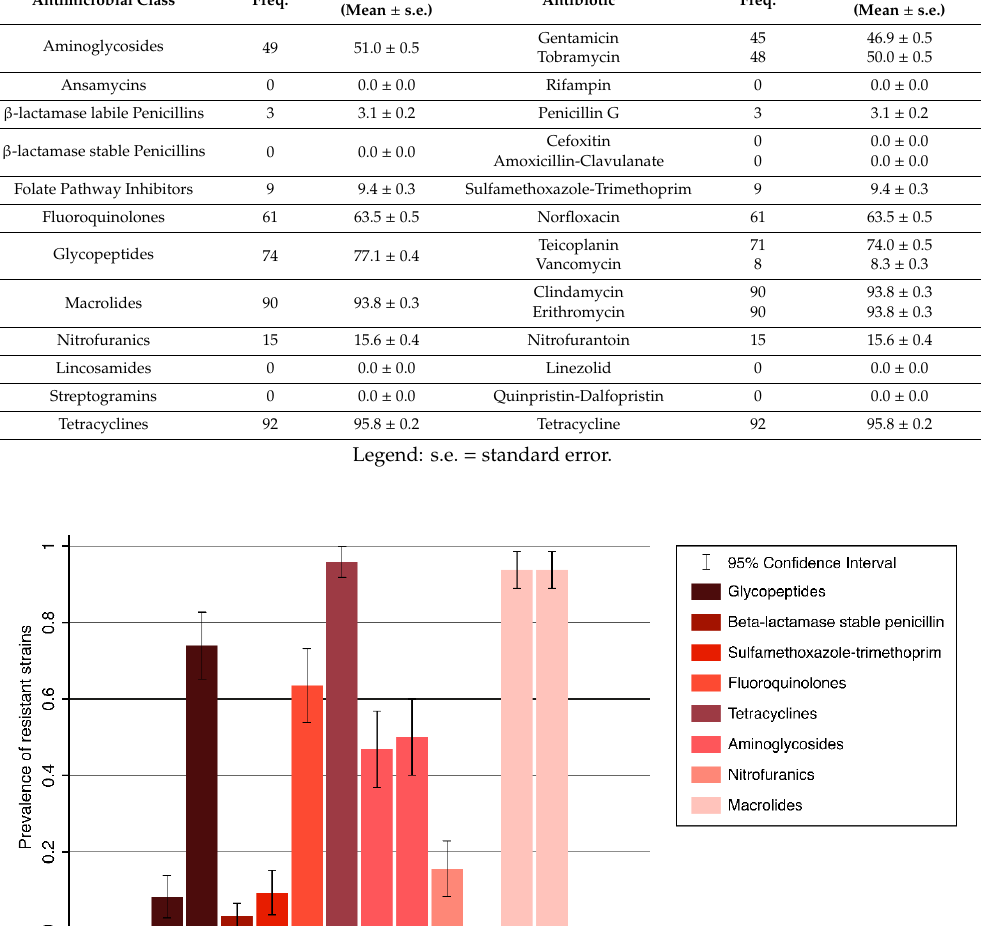
Table 1. Frequency and resistance prevalence against the 12 antimicrobial classes and 16 antibiotics. Antimicrobial Class